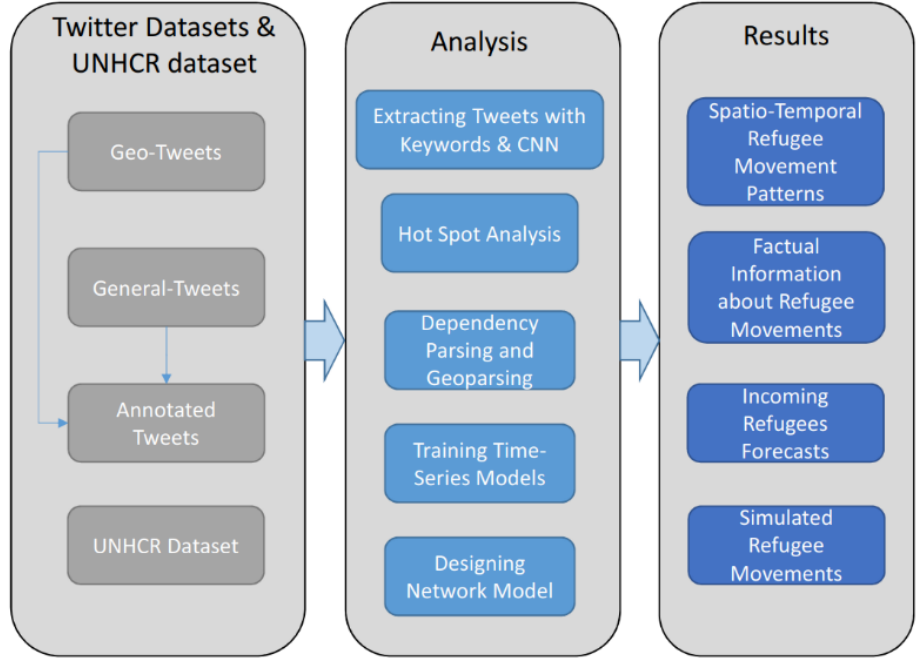
Figure 5. High-level schematic illustration of our proposed